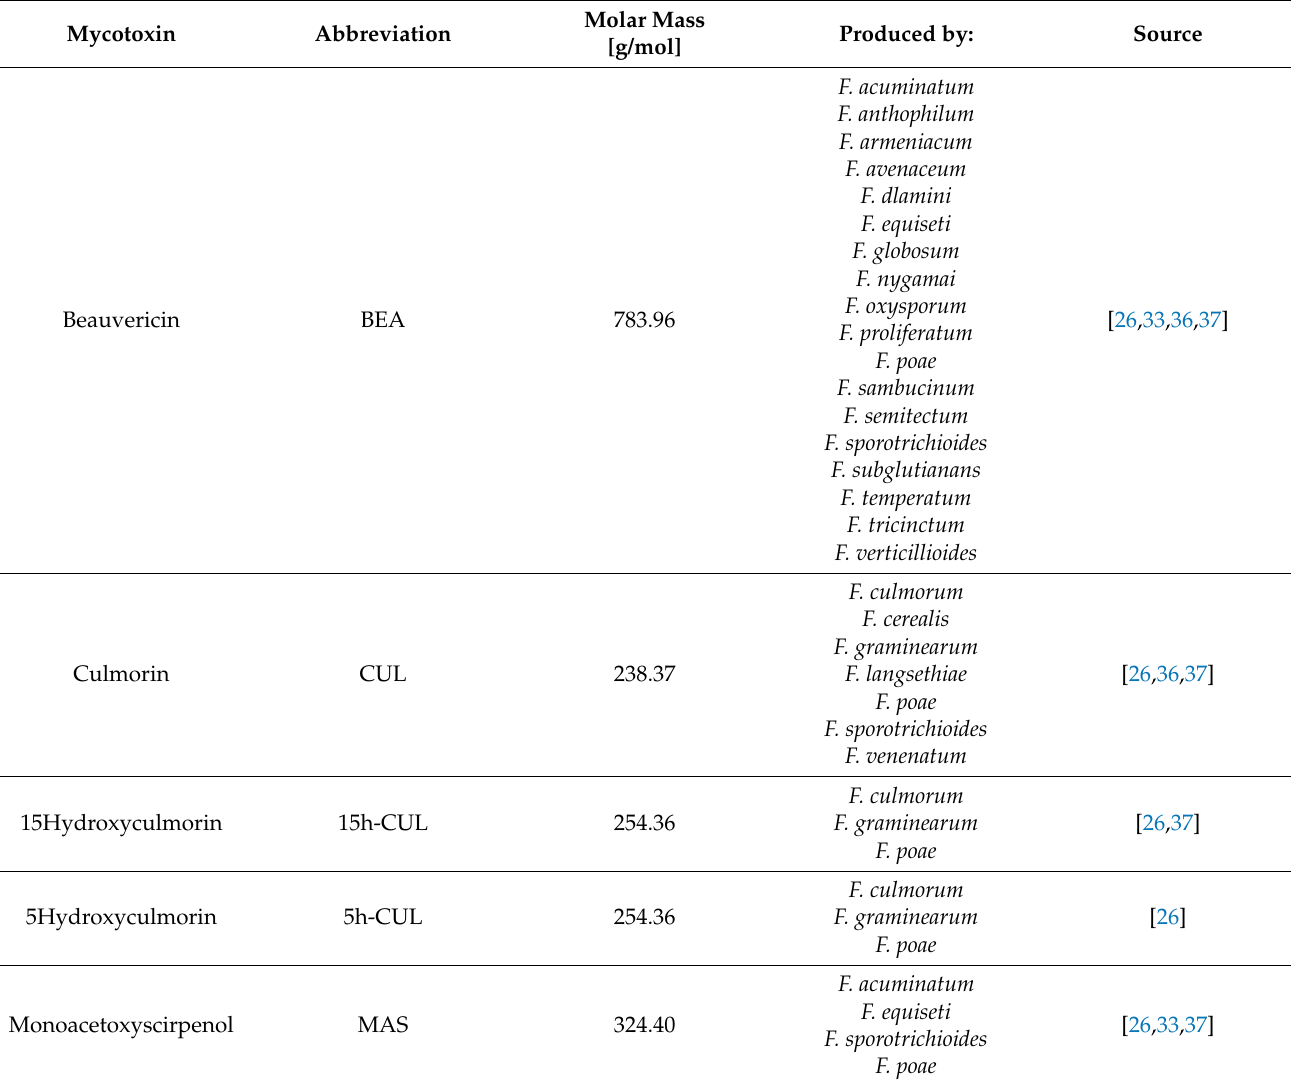
Table 3. Selected “emerging” toxins produced by Fusarium fungi, identified in